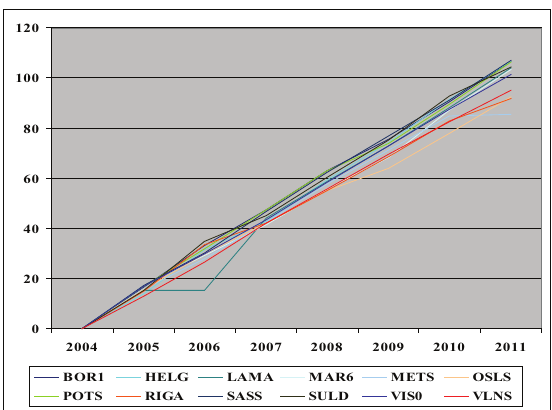
Fig. 4. The displacements of coordinate X of the stations (mm)